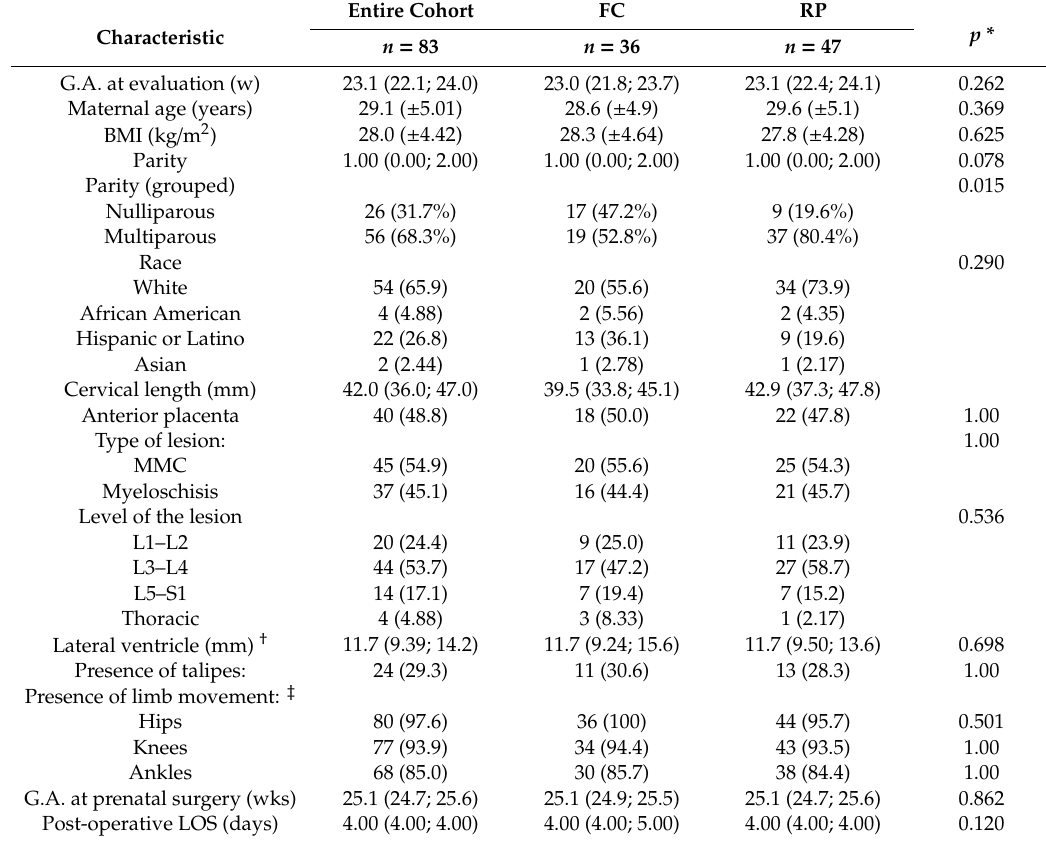
Table 1. Baseline and operative characteristics of the study population ( n = 82).